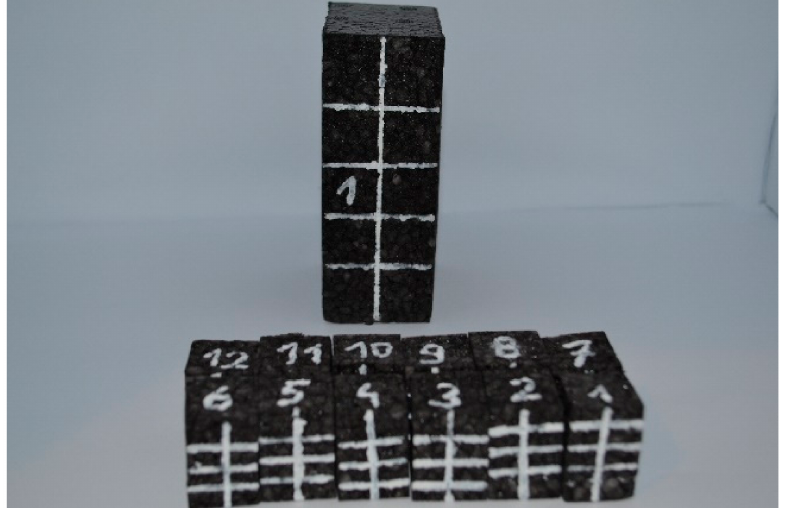
Figure 3. Tested specimens EPP foam.